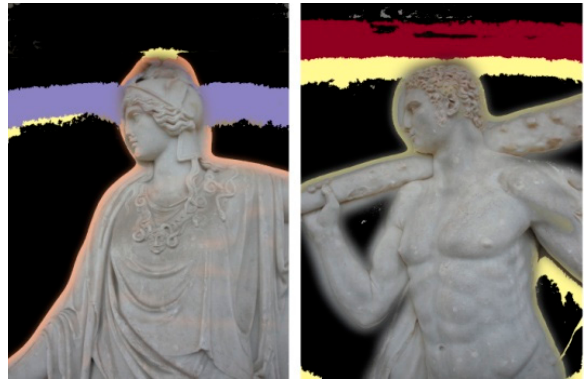
Figure 3. Images obtained through an image editor software. Author: Matteo Romanato.